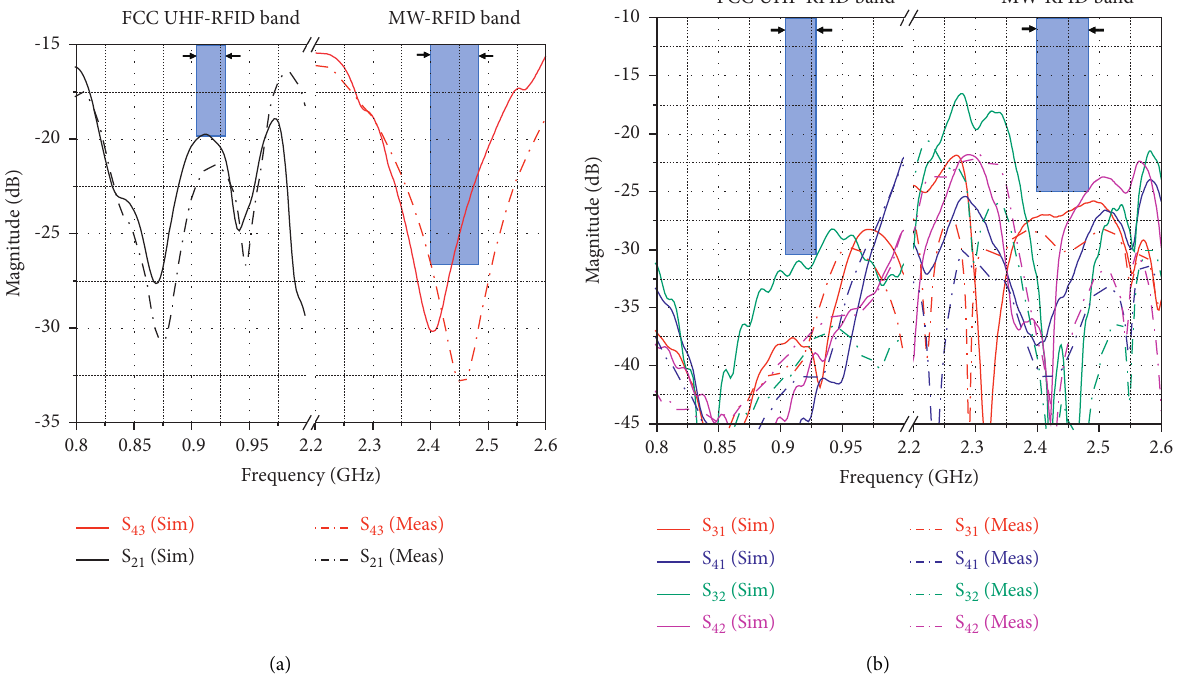
Figure 9: Simulated and measured isolation of (a) same-band ports and (b) different-band ports.